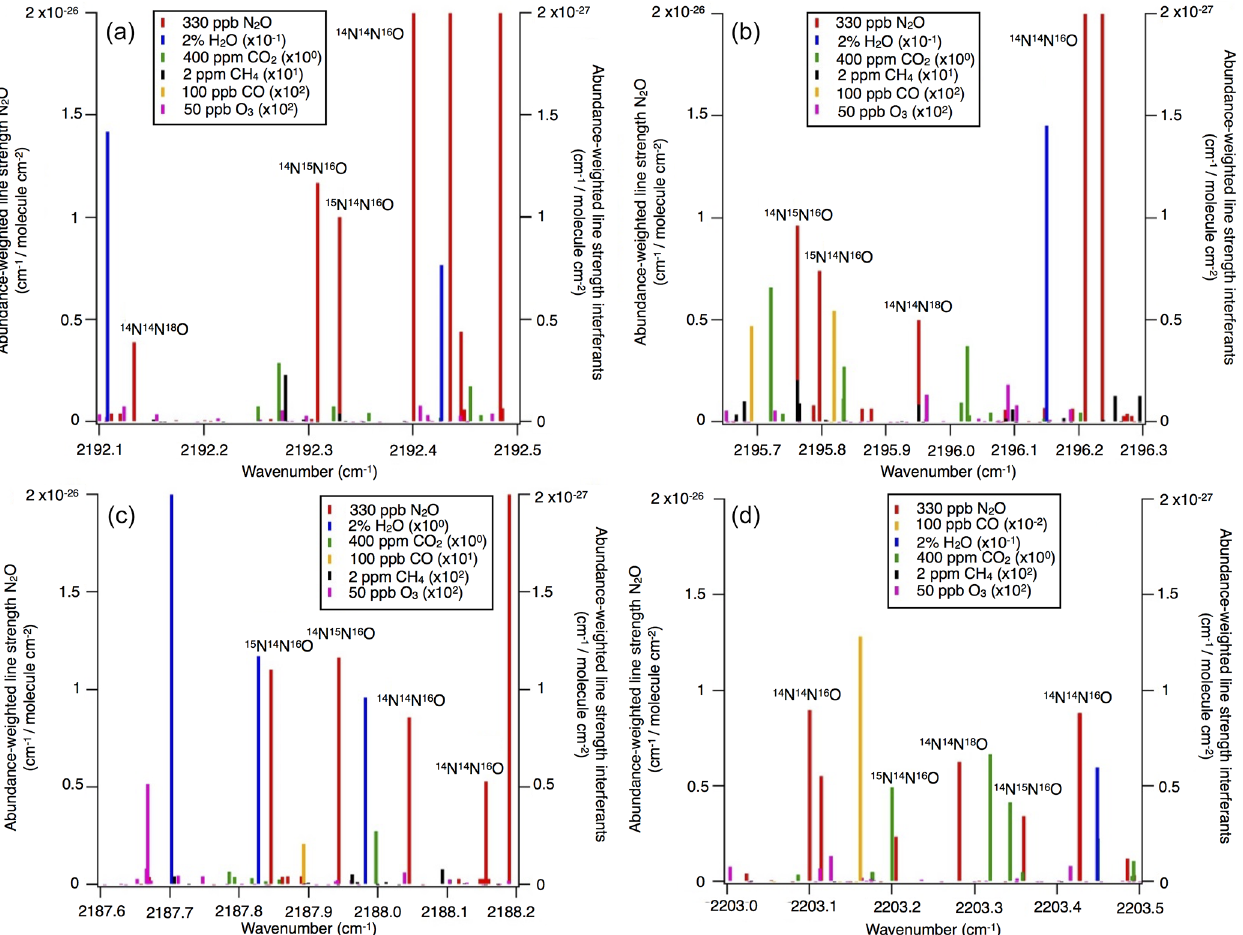
Figure 1. N 2 O isotopocule absorption line positions in the wavenumber regions selected for (a) OA-ICOS, (b) CRDS and (c, d) QCLAS techniques. Regions of possible spectral overlap from interfering trace gases such as H 2 O, CO 2 , CH 4 and CO are shown. The abundance- scaled line strengths of trace gases have been scaled with 10 − 1 to 10 2 (as indicated) because they are mostly weaker than those of the N 2 O